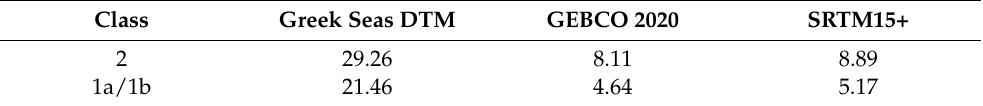
Table 6. Percentage of values for each model based on error percentage